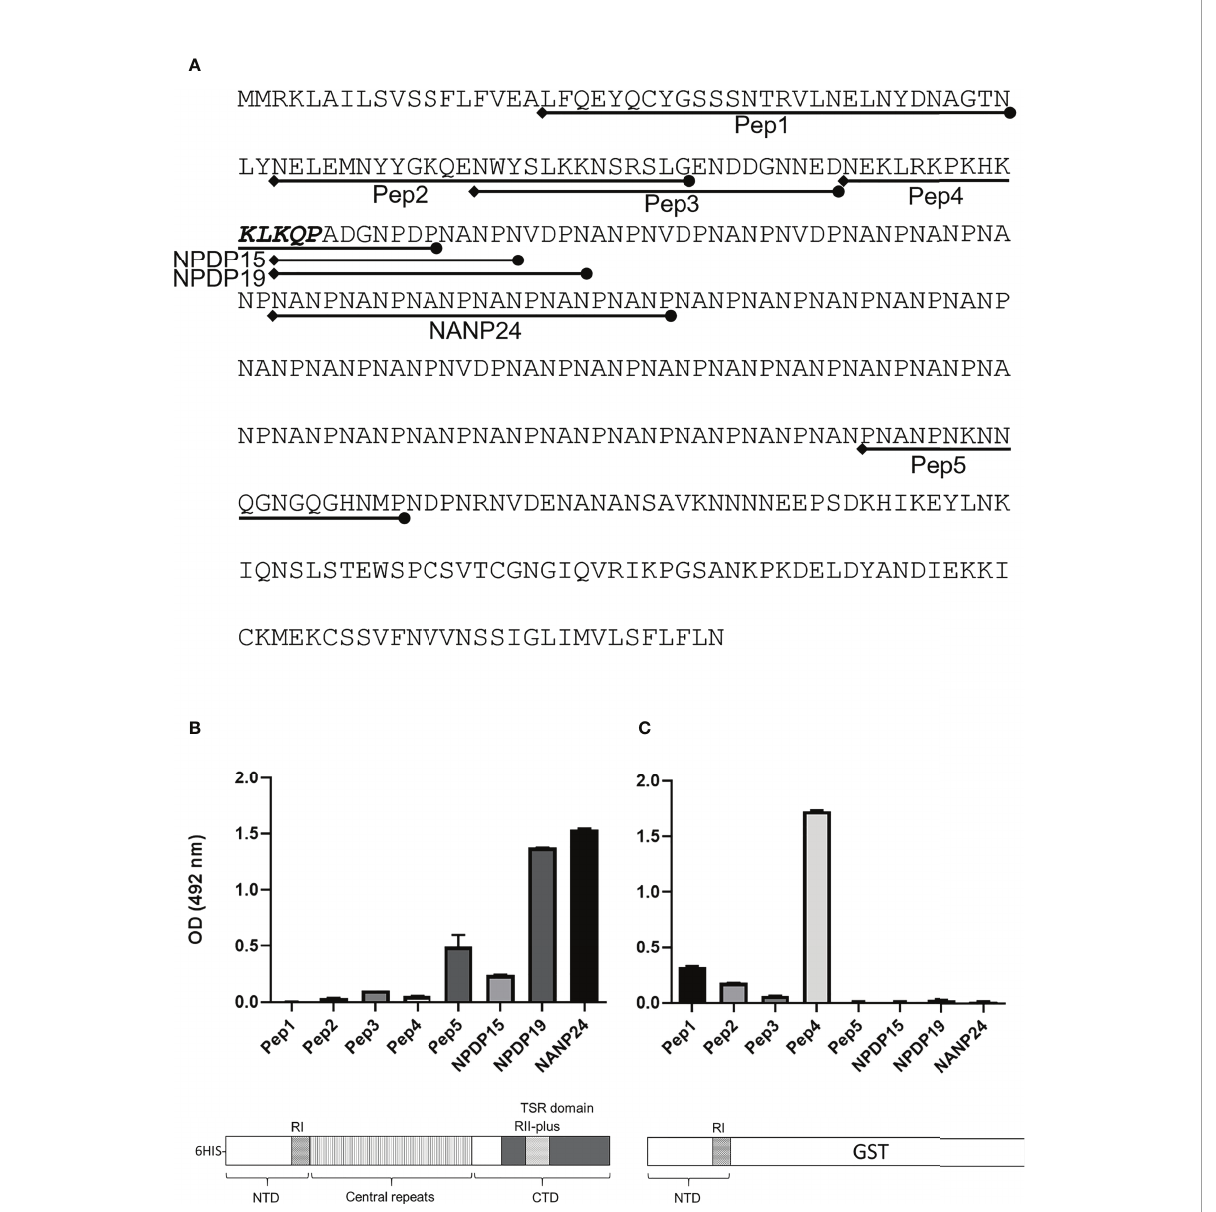
FIGURE 8 Antibody response against CSP peptides. Mice were immunized with either FL-CSP or NTD-GST. (A) Sequences of CSP peptides tested in the ELISA assays delineated on the amino-acid sequence of CSP. (B) Antibody levels in a serum pool of 4 mice immunized with FL-CSP against CSP peptides representing the NTD (Pep1, Pep2, Pep3, and Pep4), junction region (NPDP15 and NPDP19), central repeat region (NANP24) and the CTD (Pep5). (C) Antibody levels in a serum pool of 4 mice immunized with